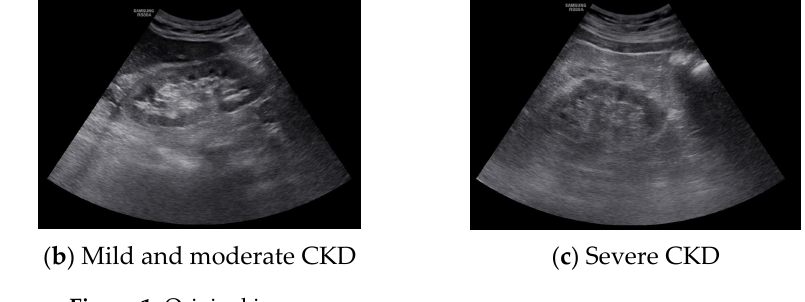
Figure 1. Original images.